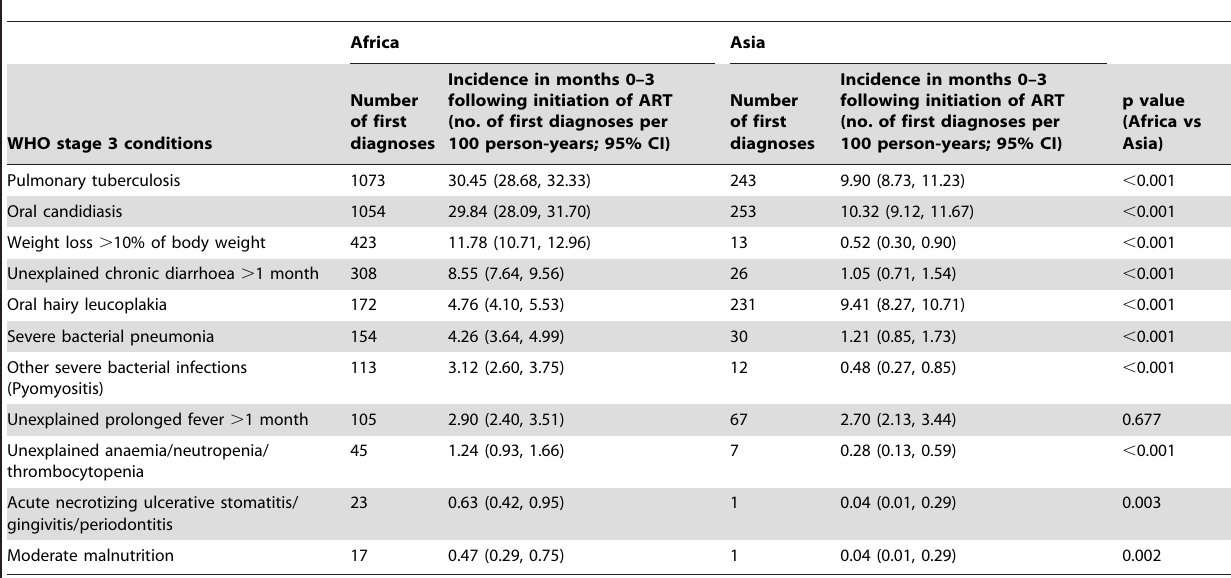
Table 4. Regional disease specific incidence of WHO stage 3 conditions in months 0–3 following ART